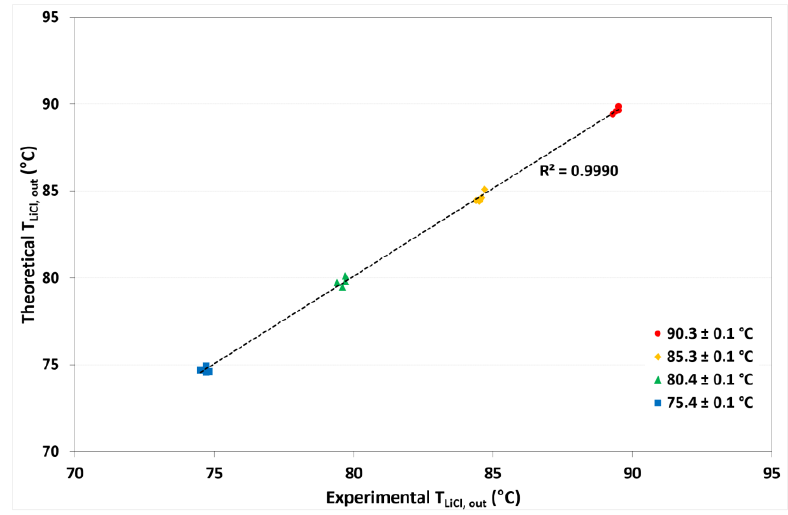
Figure 10. Comparison between theoretical and experimental outlet solution temperatures.